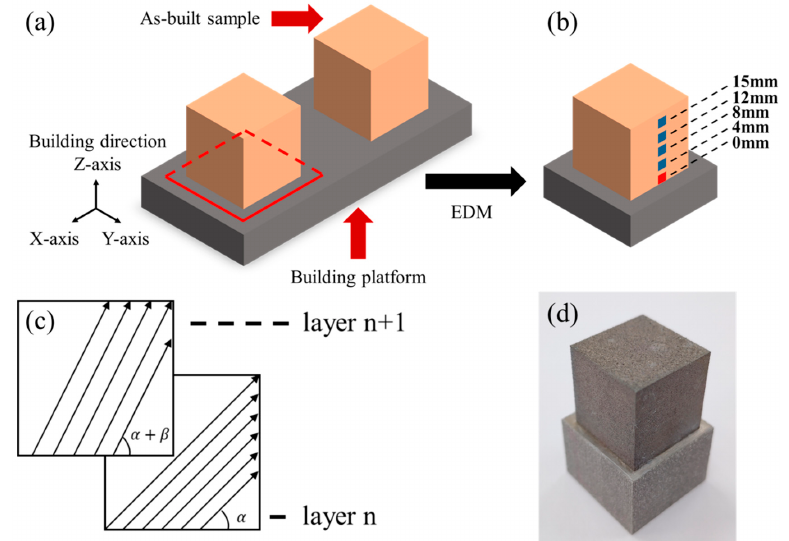
Figure 1. ( a ) Schematic representation of electrical discharge machining (EDM) processing on as-built samples. EDM cutting path are represented by red lines. ( b ) Schematic representation of XRD measuring points. Measurements at 0 mm (red area) on same sample before and after surface finishing were used to evaluate the e ff ect of surface roughness on XRD measurements. Four additional measurements (blue area) were performed on surface finished sample to acquire residual stress distribution. ( c ) Representation of scanning strategies (starting angle α and rotation angle between subsequent layers β ). ( d ) As-built sample cut together with building